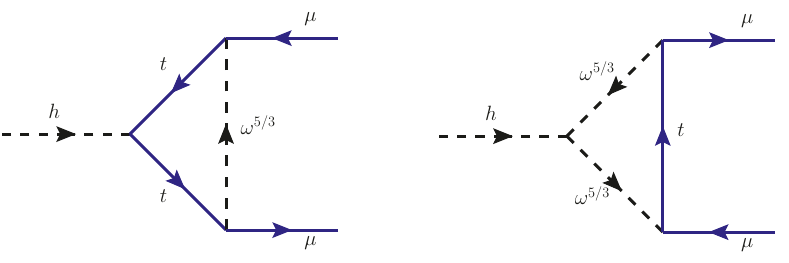
Figure 5 . Feynman diagrams for the LQ contribution to h → µ + µ − (and also τ + τ − ) in our model. and significant discrepancy. In particular, we set f ∆ a contribution for our numerical fits discussed in section e